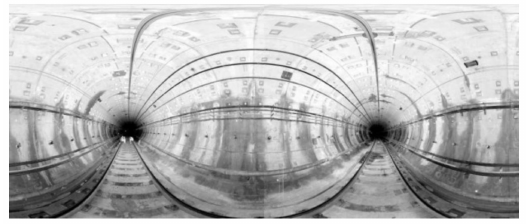
Figure 9. Test tunnel site.